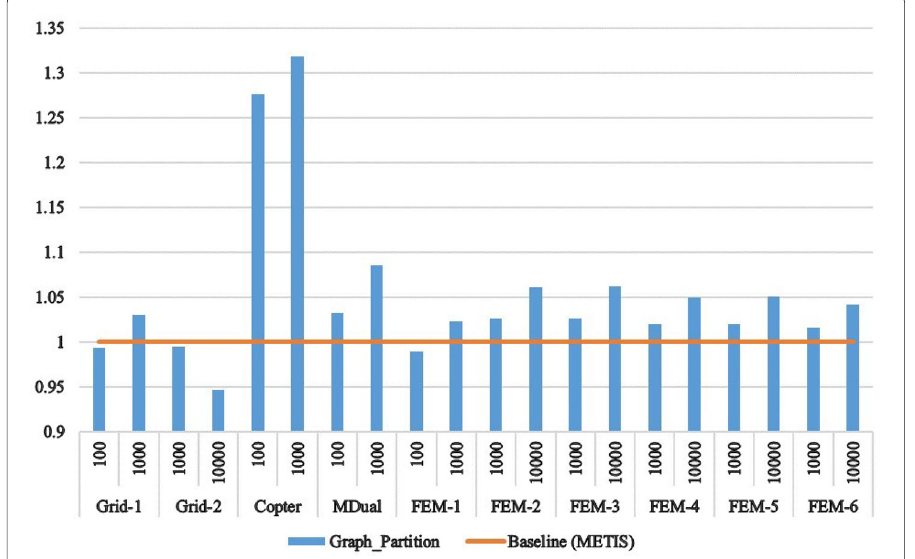
Fig. 9 The ratios of max-load of our algorithm to that of